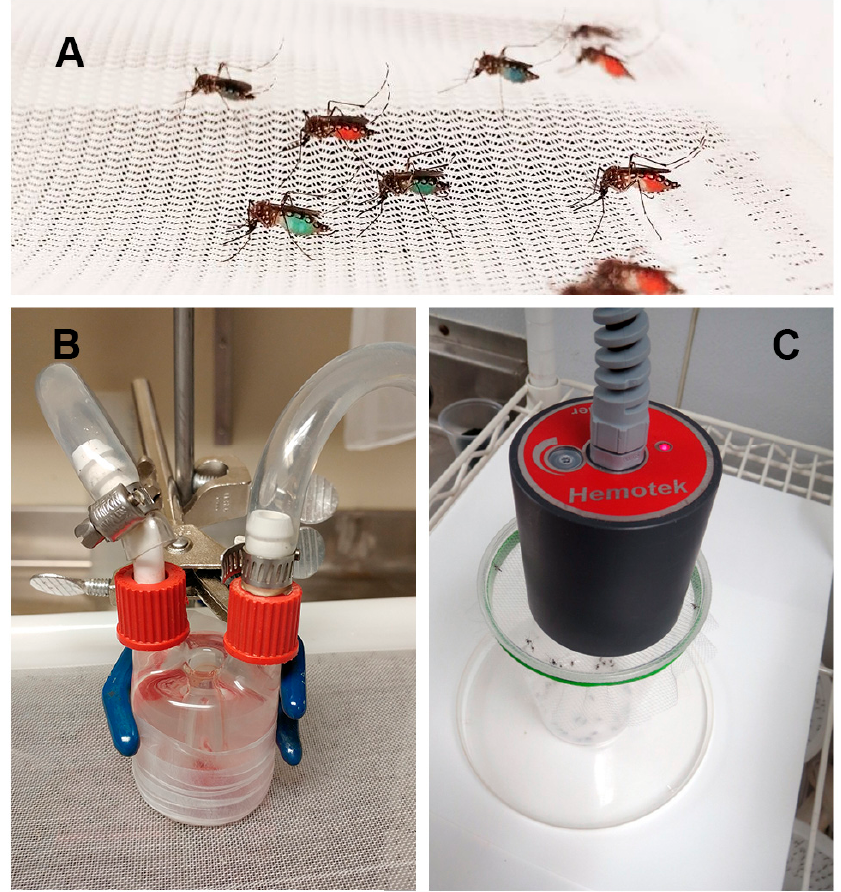
Figure 1. Artificial feeding systems for mosquitoes. ( A ) Aedes aegypti mosquitos engorged on an artificial blood meal replacement diet. Food colors were added to the different SkitoSnacks; ( B ) Glass membrane feeder for mosquitoes. Warm water is used in this device to keep the meal at body temperature. Mosquitoes suck the meal through a Parafilm ® membrane (Sigma Aldrich, St. Louis, MO, USA); ( C ) Hemotek feeding system (Hemotek Ltd., Great Harwood,